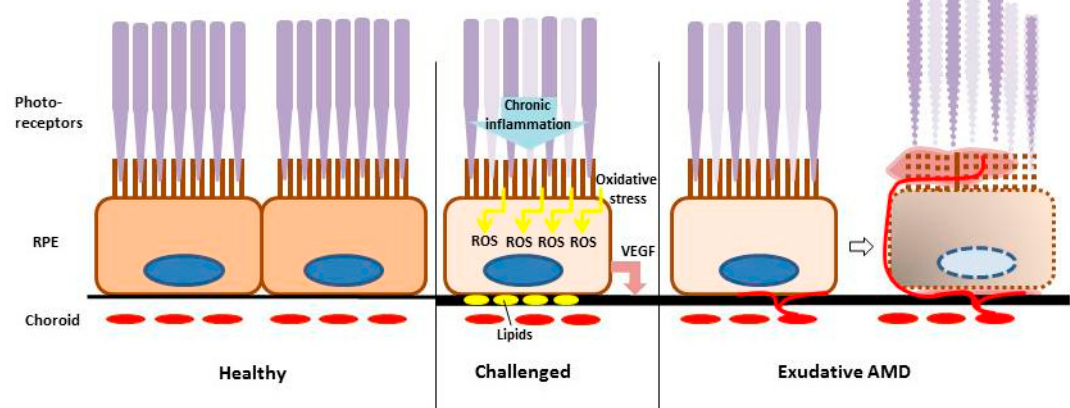
Figure 1. Schematic of (exudative) age-related macular degeneration (AMD) pathogenesis. Retinal pigment epithelium (RPE) cells interact with photoreceptors (purple) and the choroid (red). In AMD development, RPE cells are challenged with oxidative stress, chronic inflammation, and lipid deposits which impair their function and increase VEGF secretion. This may lead to neovascularization from the choroid under and into the retina and to degeneration of the RPE and the photoreceptors; ROS = reactive oxygen species; VEGF = vascular endothelial growth factor.